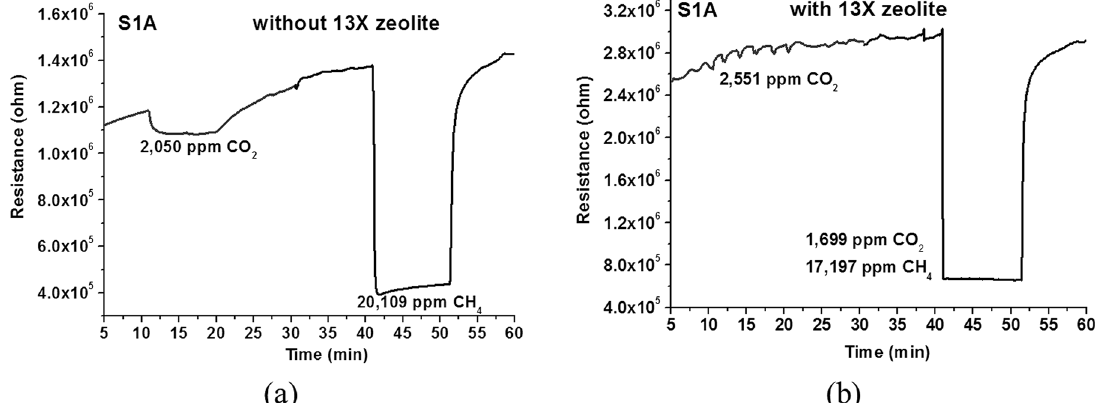
and CH analyzed by sensor S1A without (a) and with (b) 13X zeolite pellets filter. 2 4 . 4